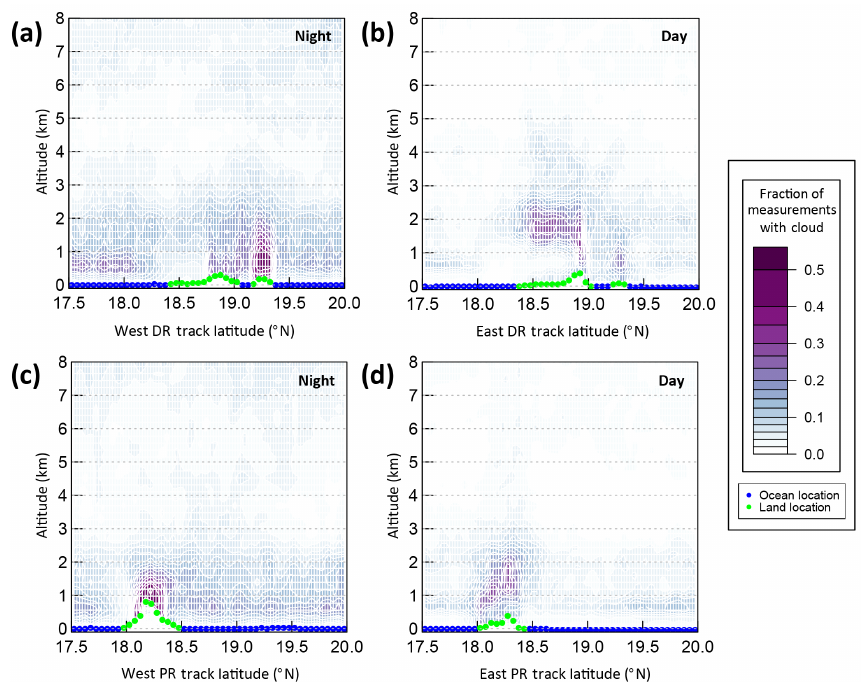
Figure 6. CALIPSO satellite data fraction of measurements with cloud recorded in cell, for the years 2006–2016, with cell at 0.05 ◦ latitude along track and 30m altitude for the (a) west Dominican Republic (DR) track (night orbit), (b) east DR track (day orbit); (c) west Puerto Rico (PR) track (night orbit); and (d) east PR track (day orbit). Since track measurement location varies slightly, surface point (land or ocean) is plotted as the mean location. Cell fractions are spline-smoothed into a surface. Tracks are marked on Fig.